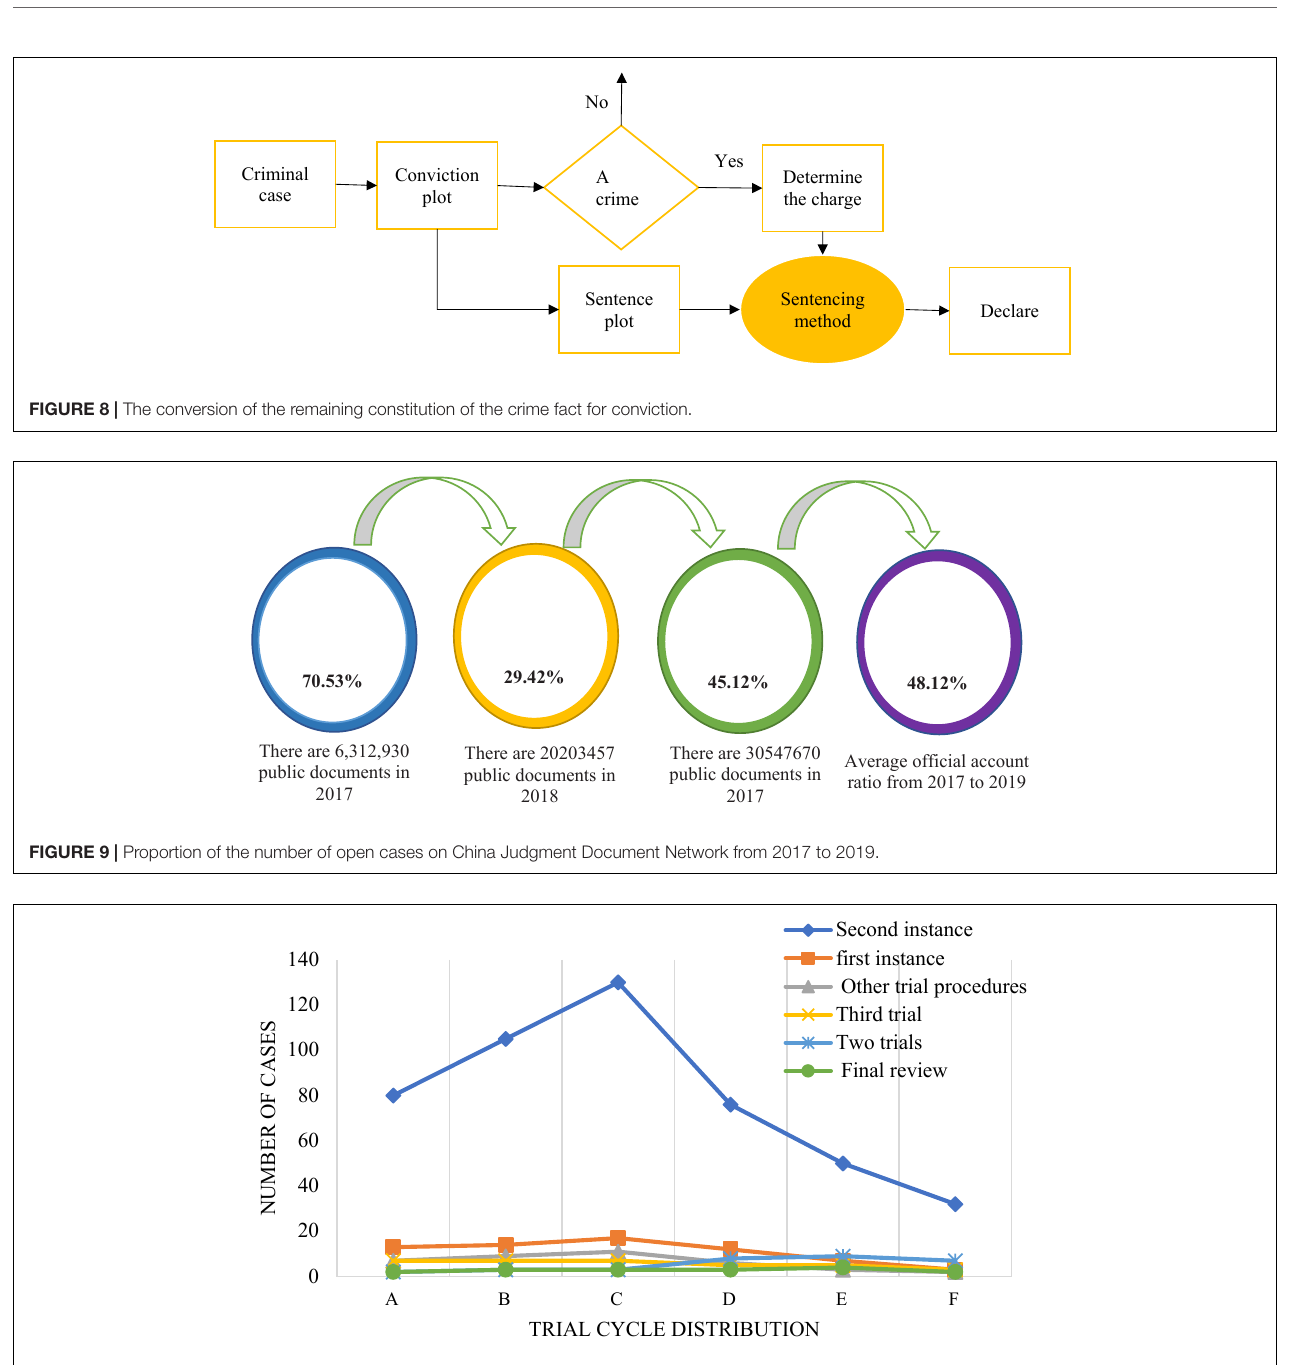
FIGURE 10 | Case trial cycle. (A: < = 2 months; B: 2–4 months; C: 4 ∼ 6 months; D: 6 ∼ 8 months; E: 8 ∼ 10 months; F: > 10 months).